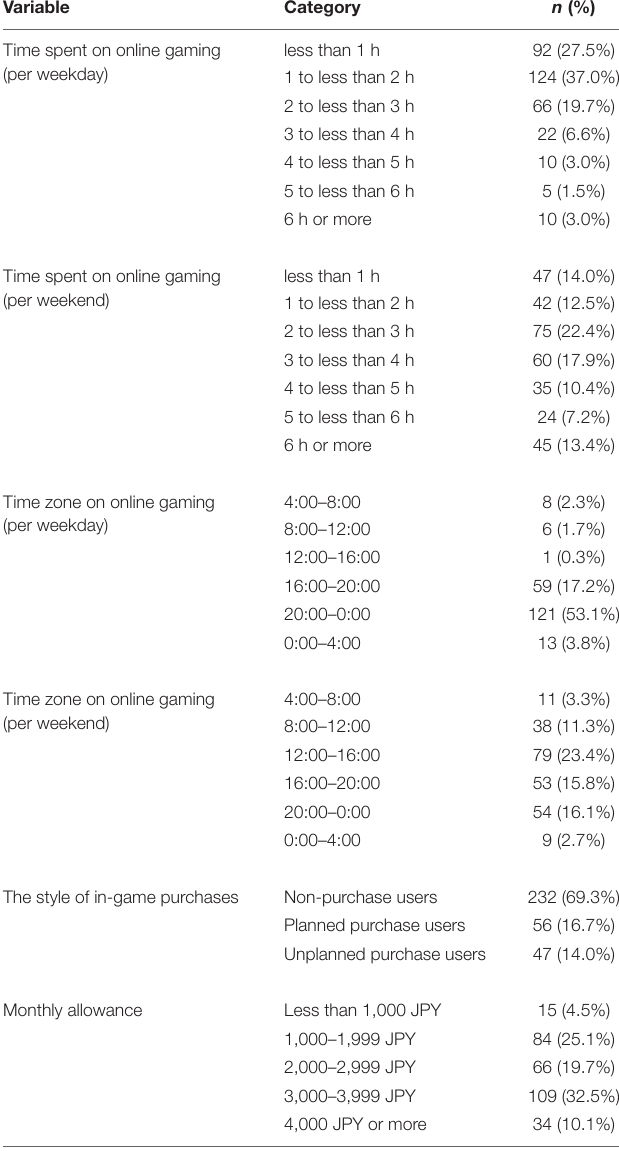
TABLE 1 | Demographic characteristics ( N =